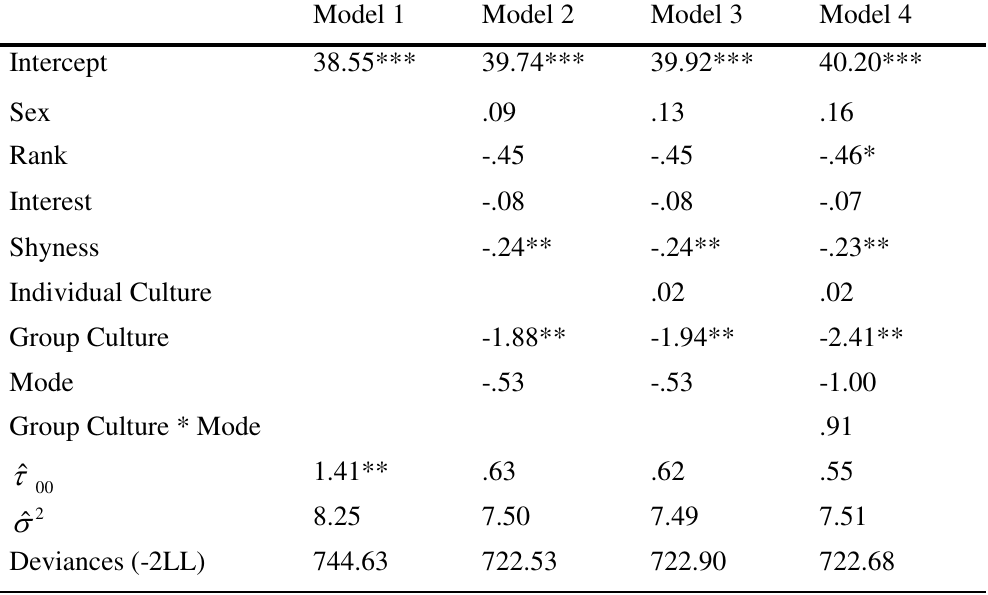
Table 1. Coefficient Estimates of Independent Variables for Self-Assessment of